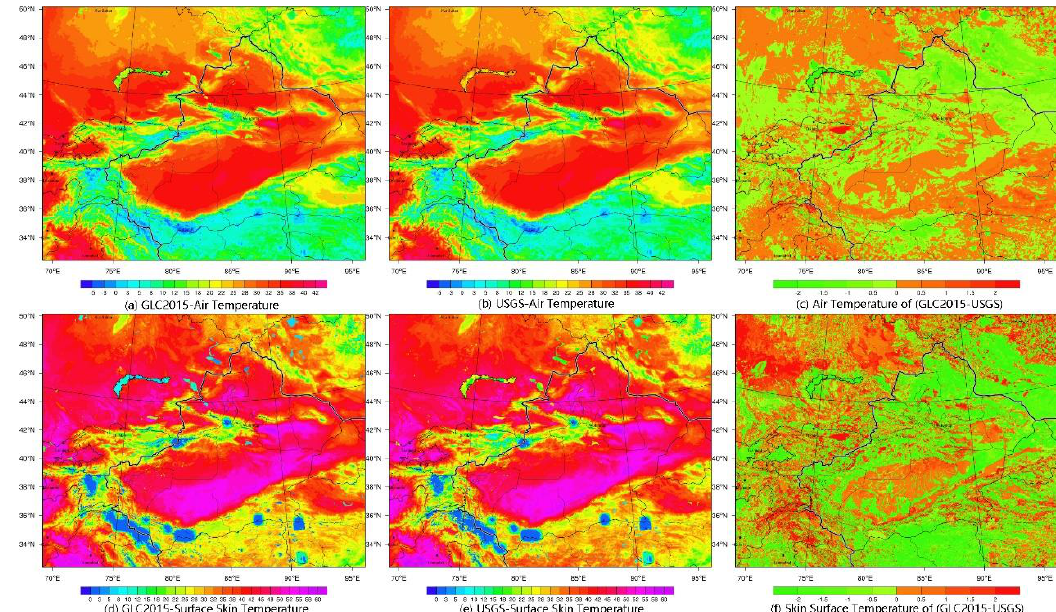
Figure 7. Contrast maps of air temperature and skin surface temperature of GLC2015 ( a,c ) and USGS ( b,d ) and their di ff erences at 6:00 UTC, 11 July 2018.